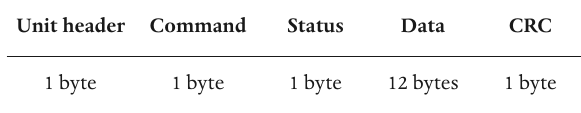
Table 1. Cell format of data frames in an acquisition station. CRC, cyclic redundancy check